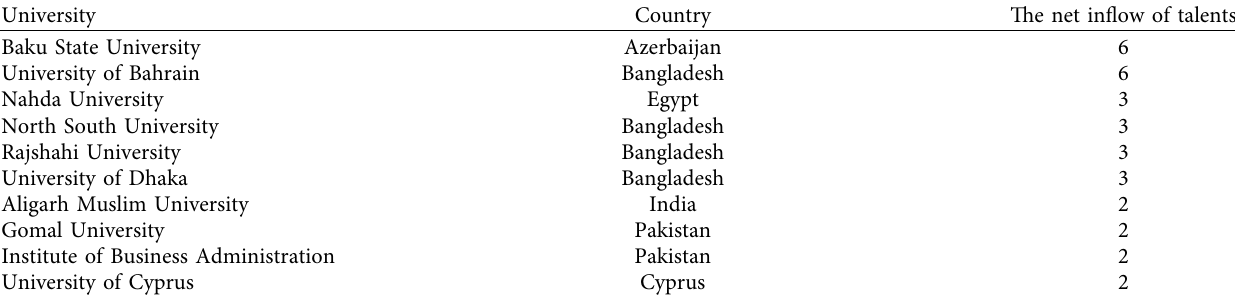
Table 4: The ranking of the attractiveness for postgraduate studies (top 10).